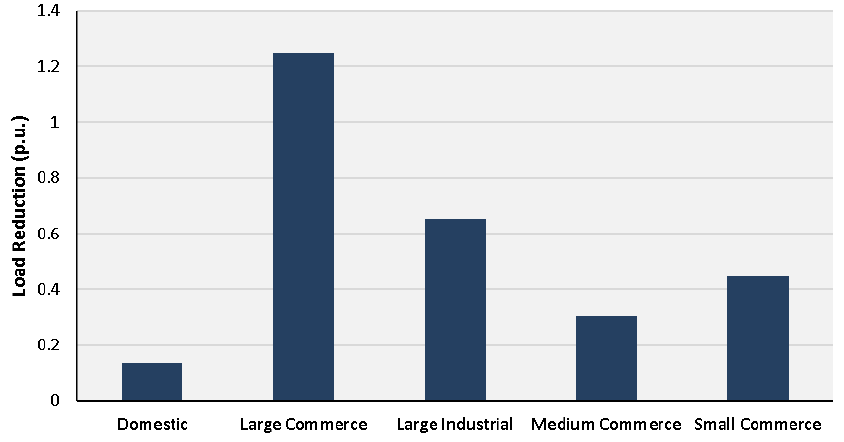
Figure 4. Curtailment capacity in all periods by type of consumer.